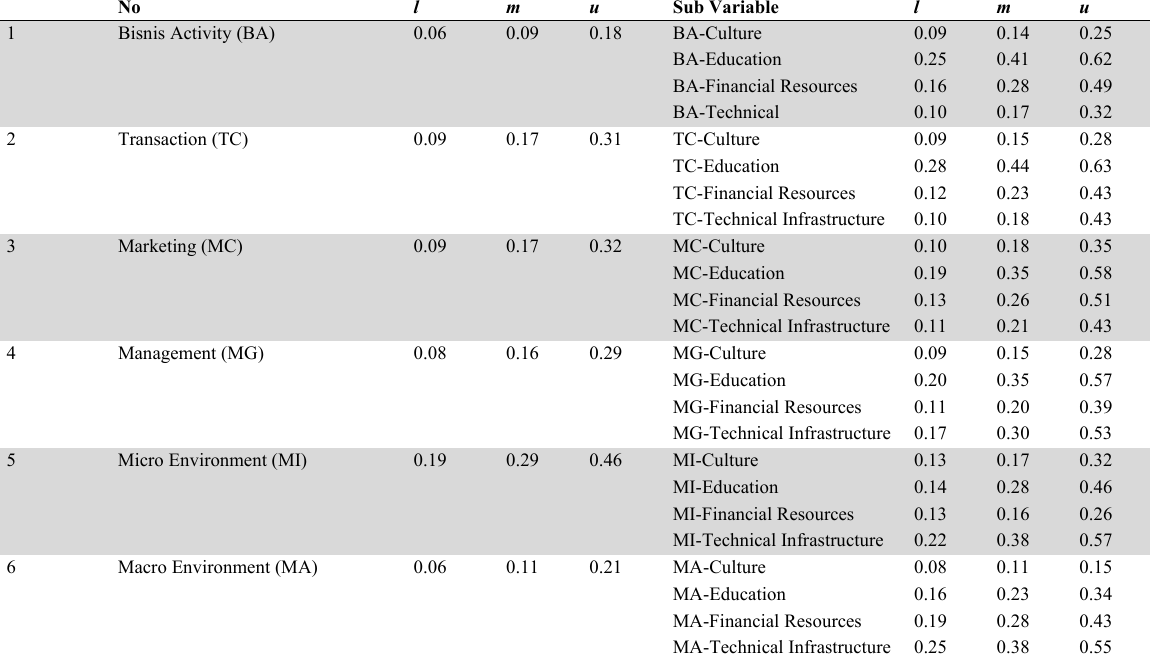
The recapitulation of fuzzy synthesis values